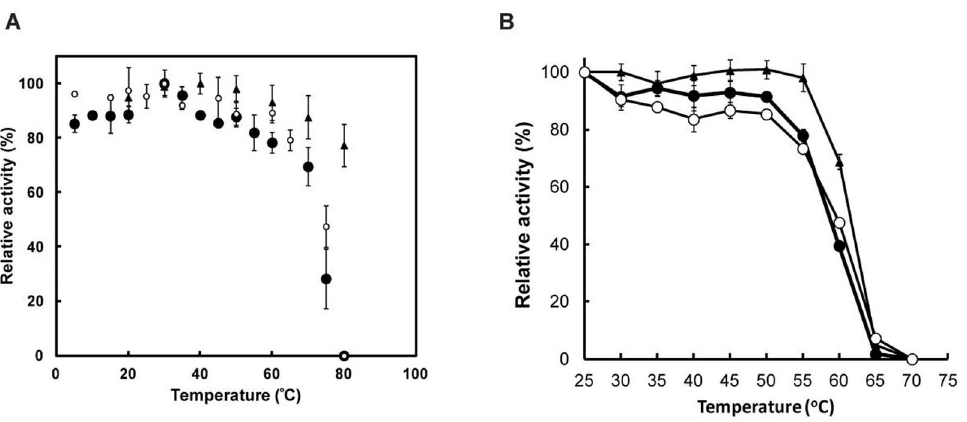
Figure 2. Effects of temperature on activities and stabilities of extracellular and intracellular catalases of E . oxidotolerans T-2-2 T . (A) Effect of temperature on catalase activity. Extracellular and intracellular catalases are indicated by filled and open circles, respectively. M . luteus catalase, indicated by closed triangles, was used as a counterpart mesophilic enzyme. Catalase activity was assayed, as described in Materials and Methods, at the temperature indicated. (B) Temperature stability of catalase. Symbols are indicated as in (A). The enzyme was incubated for 15 min at the indicated temperatures prior to activity measurement. Catalase activity was assayed at 25 u C as described in Materials and Methods.